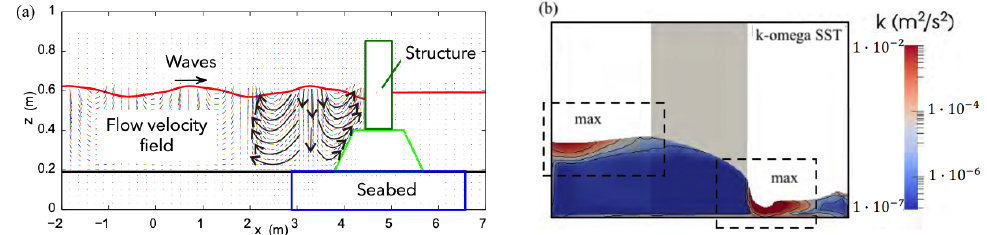
Figure 4. ( a ) The flow velocity increases around a composite vertical breakwater; ( b ) the turbulence kinetic energy ( k = u 2 + v 2 + w 2 ) increases at the toe of the seawall. Both of the figures are adapted from 2 the numerical simulations to study the interactions between ocean waves and maritime structures performed by Ye et al. [53] and Higuera [54], respectively.